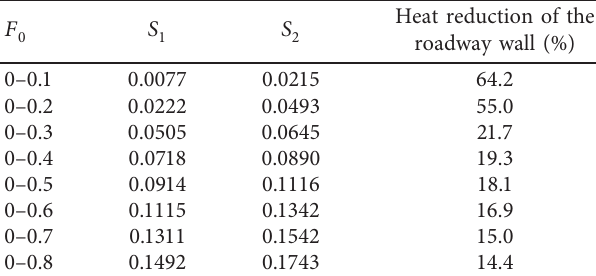
Table 6: Calculation of heat reduction of the roadway wall at different